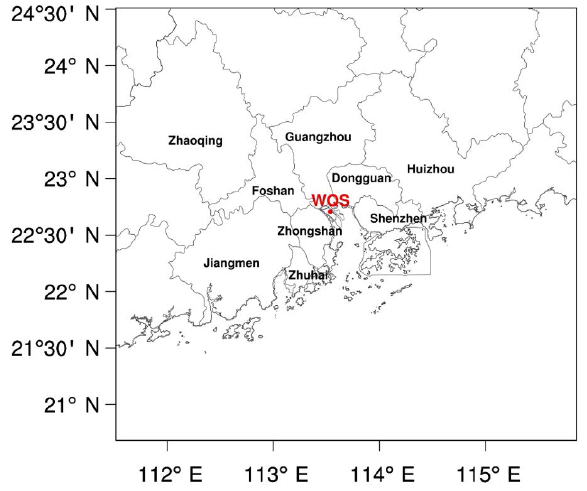
Figure 1. Modeling domain and locations of Wan Qing Sha air qual- ity monitoring